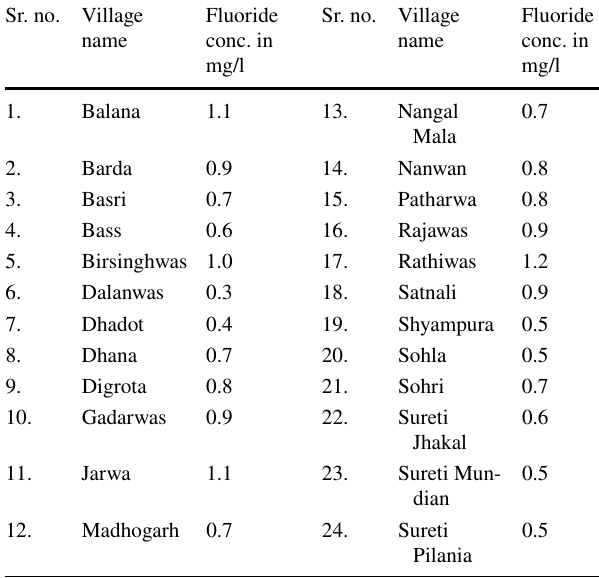
Table 1 Showing the average fluoride concentration in villages of block Satnali district